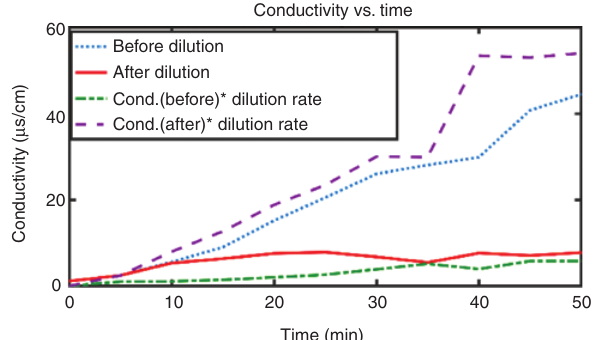
Table 2: Relationship between NSC conductivity before and after dilution and the dilution ratio.